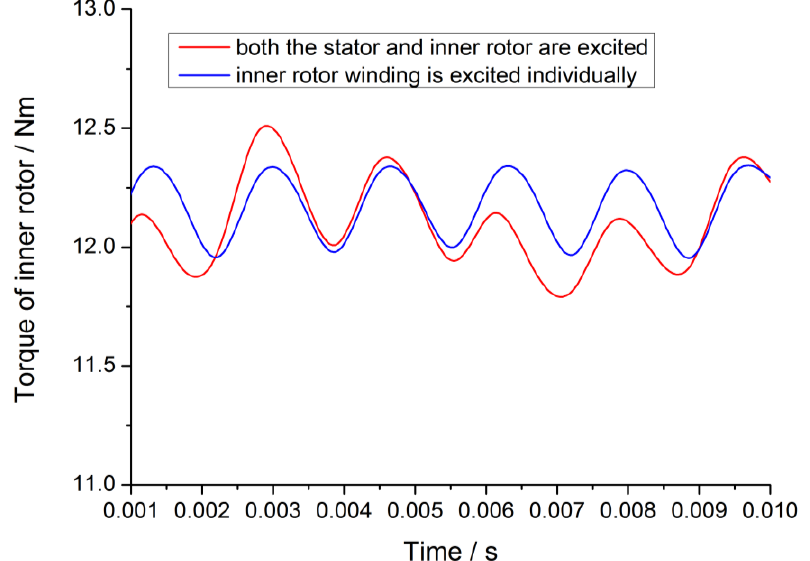
Figure 19. The torque waveforms of the inner rotor in different